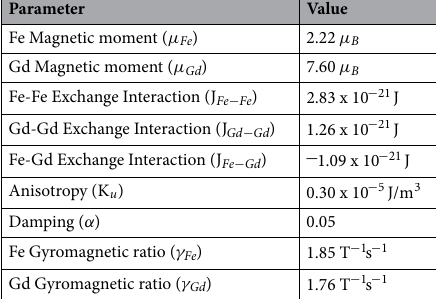
Table 1. Parameters used for modeling magnetization dynamics in FeGd, which were obtained from Ostler el al. and Radu et al. 14,42 .